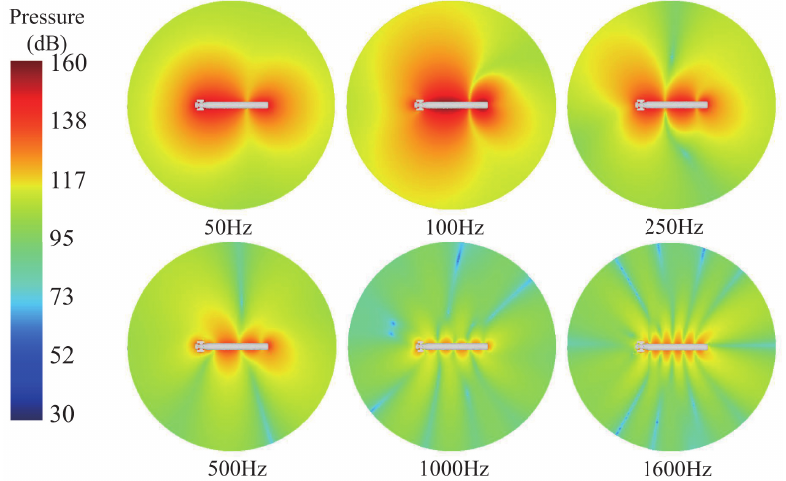
Figure 13. Sound pressure level distribution of structure-radiated noise at specific